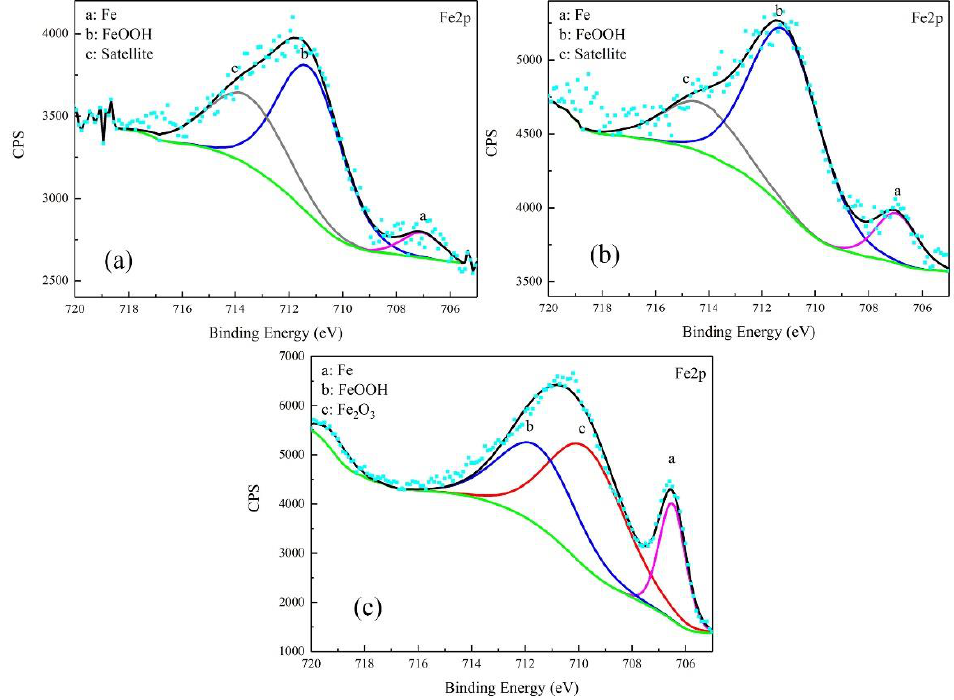
Figure 8. Detailed XPS spectra of Fe2p of corrosion products on samples after galvanostatic polarization of: 0.010 A·cm −2 ( a ); 0.030 A·cm −2 ( b ); and 0.080 A·cm −2 ( c ).